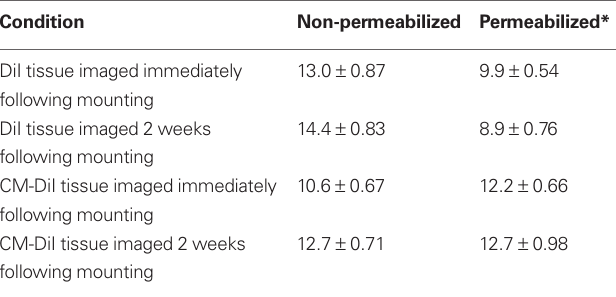
Table 1 | Spine densities (mean ± Se) for the different procedural conditions graphed in Figures 3 and